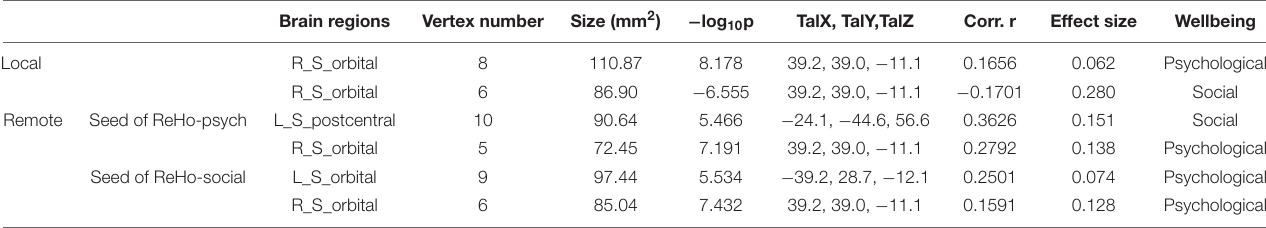
TABLE 2 | Brain regions with significant associations of wellbeing with local-to-remote cortical connectivity. Brain regions Vertex number Size (mm 2 ) − log 10